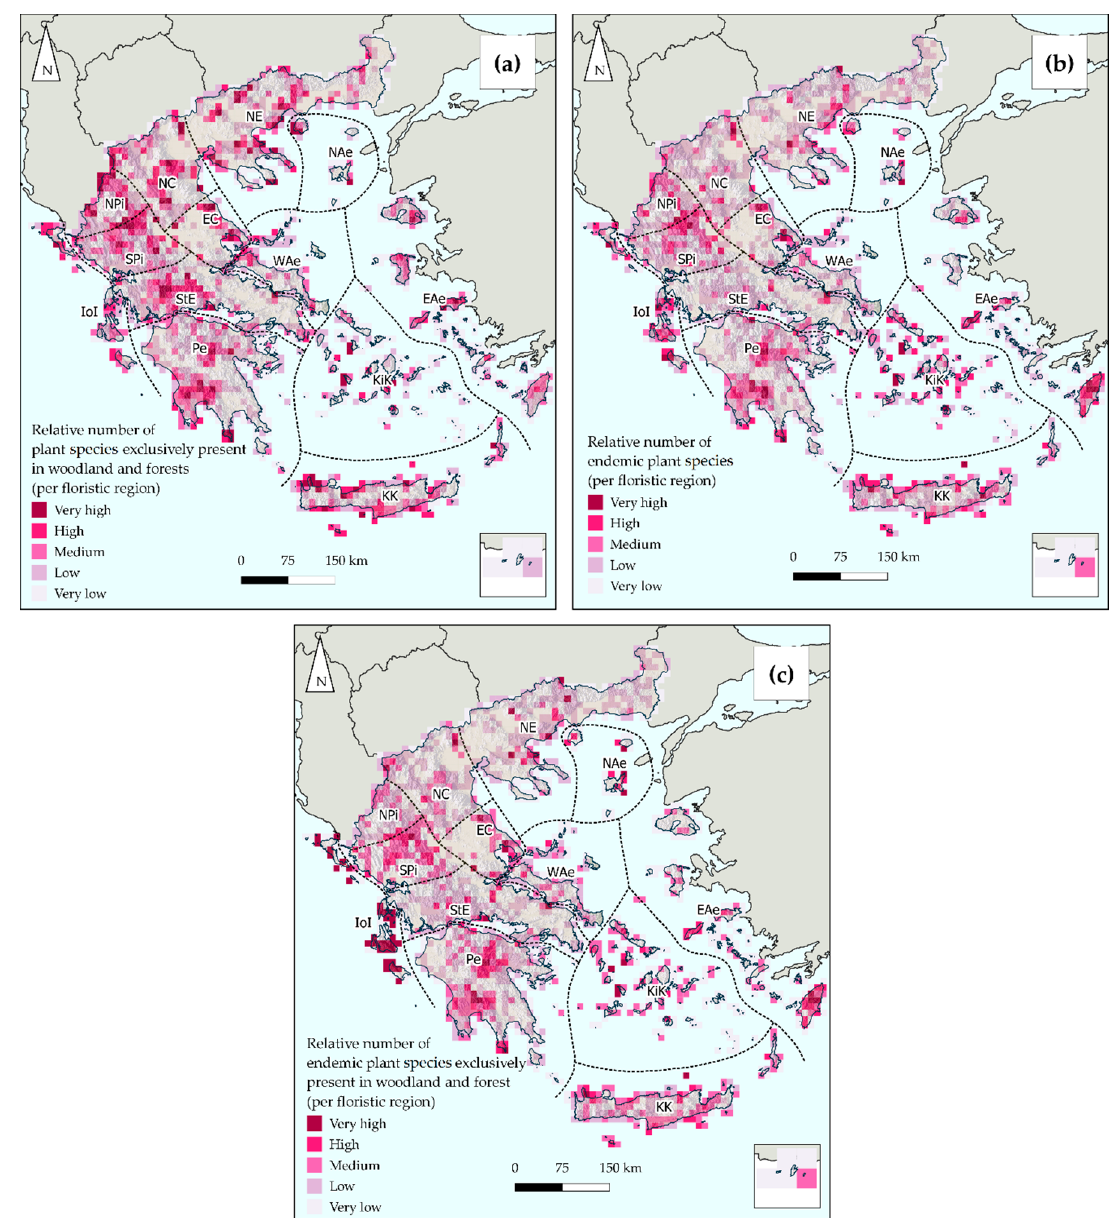
Figure 5. Thematic representation for ‘woodland and forest’ ecosystem type species richness categories at the 10 × 10 EEA reference grid level: ( a ) Relative number of species exclusively present in woodland and forest per cell, i.e., number of plant species exclusively present in woodland and forest per cell divided by the number of plant species exclusively present in woodland and forest in each floristic region (normalized); ( b ) relative number of endemic plant species present in woodland and forest per cell, i.e., number of plant species present in woodland and forest per cell divided by the number of endemic plant species present in woodland and forest in each floristic region (normalized); ( c ) relative number of endemic plant species exclusively present in woodland and forest per cell, i.e., number of endemic plant species exclusively present in woodland and forest per cell divided by the number of endemic plant species exclusively present in woodland and forest in each floristic region (normalized). Floristic regions of Greece [40,42] are also depicted: East Aegean islands (EAe), East Central Greece (EC), Ionian Islands (IoI), Kriti and Karpathos (KK), Kiklades (KiK), North Aegean islands (Nae), North Pindos (Npi), North Central Greece (NC), North-East Greece (NE), Peloponnisos (Pe), South Pindos (Spi), Sterea Ellas (StE), West Aegean islands, (Wae).